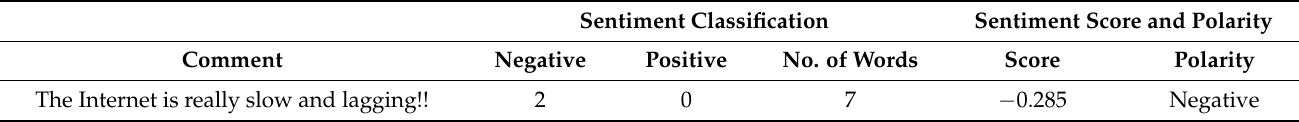
Table 3. Example of score calculation.